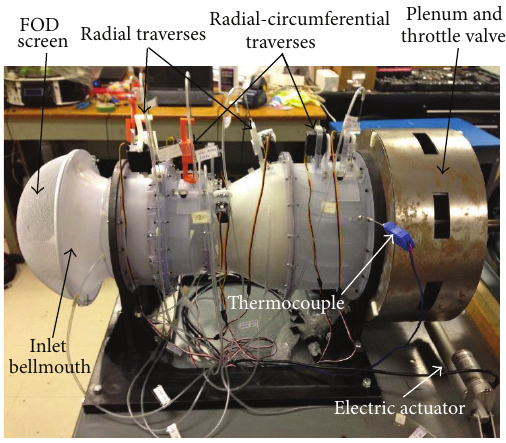
Figure 3: Side view of low-speed axial-mixed compressor test rig with instrumentation.